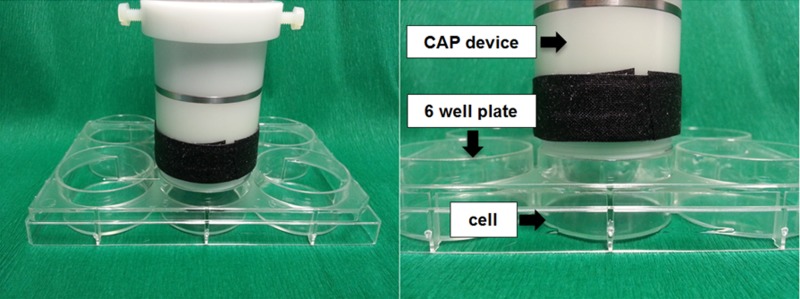
Experimental setup for CAP treatment of the HNSCC cell lines OSC-19 and FaDu.